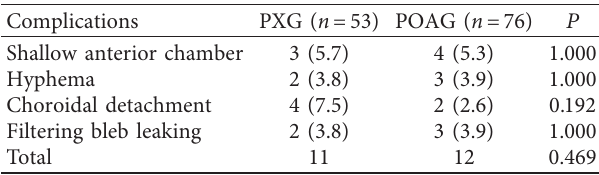
Table 4: Comparison of postoperative complications between the two groups n (%).